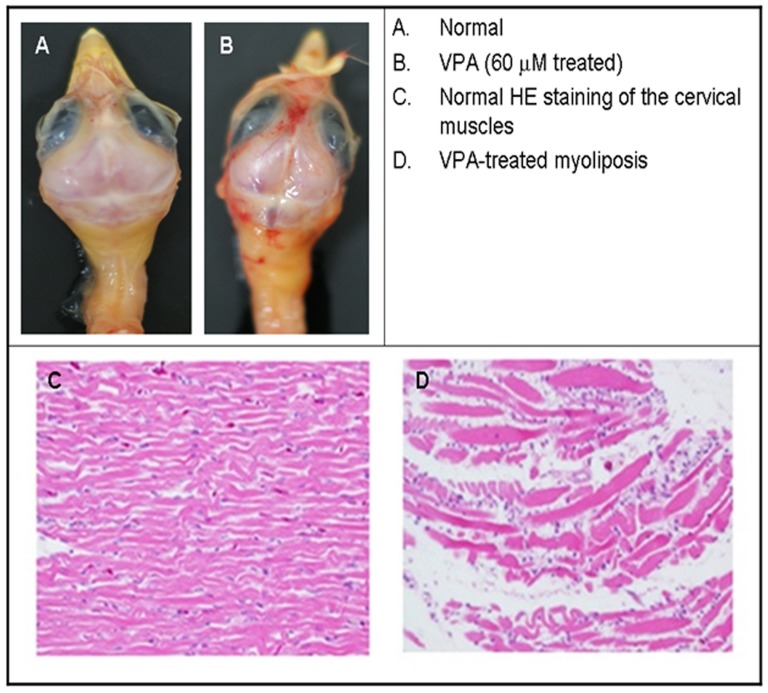
Hemorrhagic myoliposis of cervical muscles induced by VPA.Cervical musclular myoliposis (A, normal vs. B, malformed). Histopathological examination (C, normal vs. D, malformed) (magnification, 400×). Fig. D shows the completely destruction of myofibril lineages by VPA (60 µM) (n = 36).